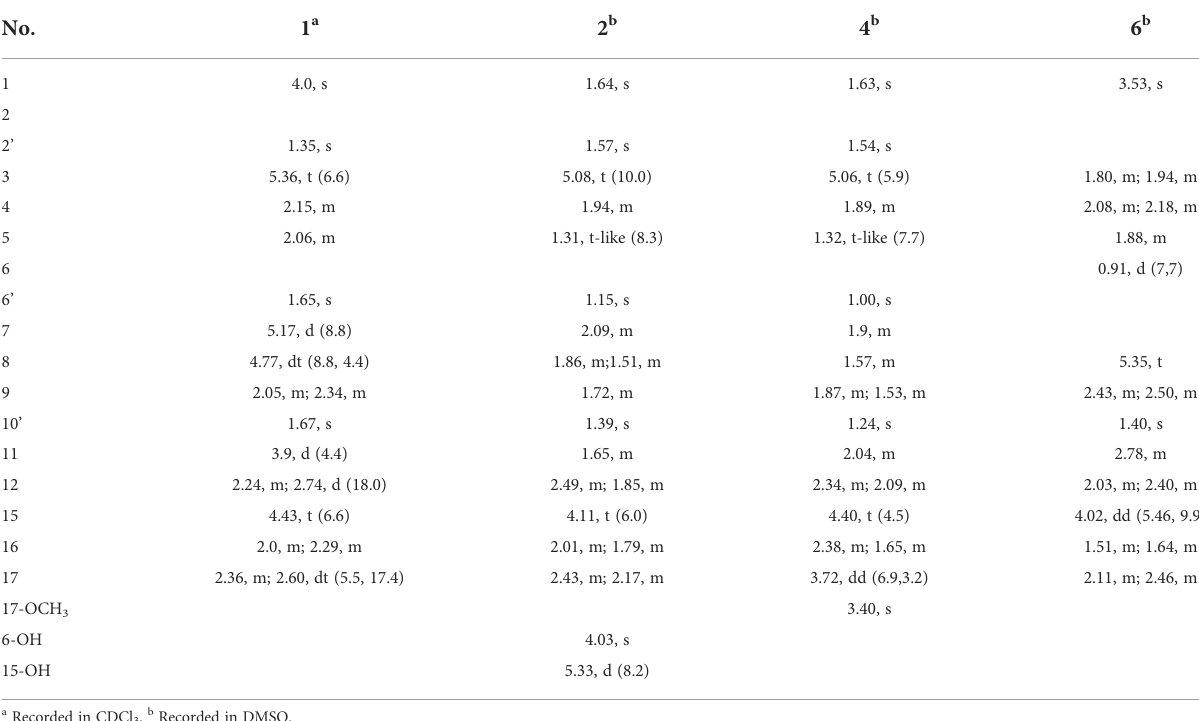
TABLE 1 1 H NMR data for compounds 1 - 2 , 4, and 6 .